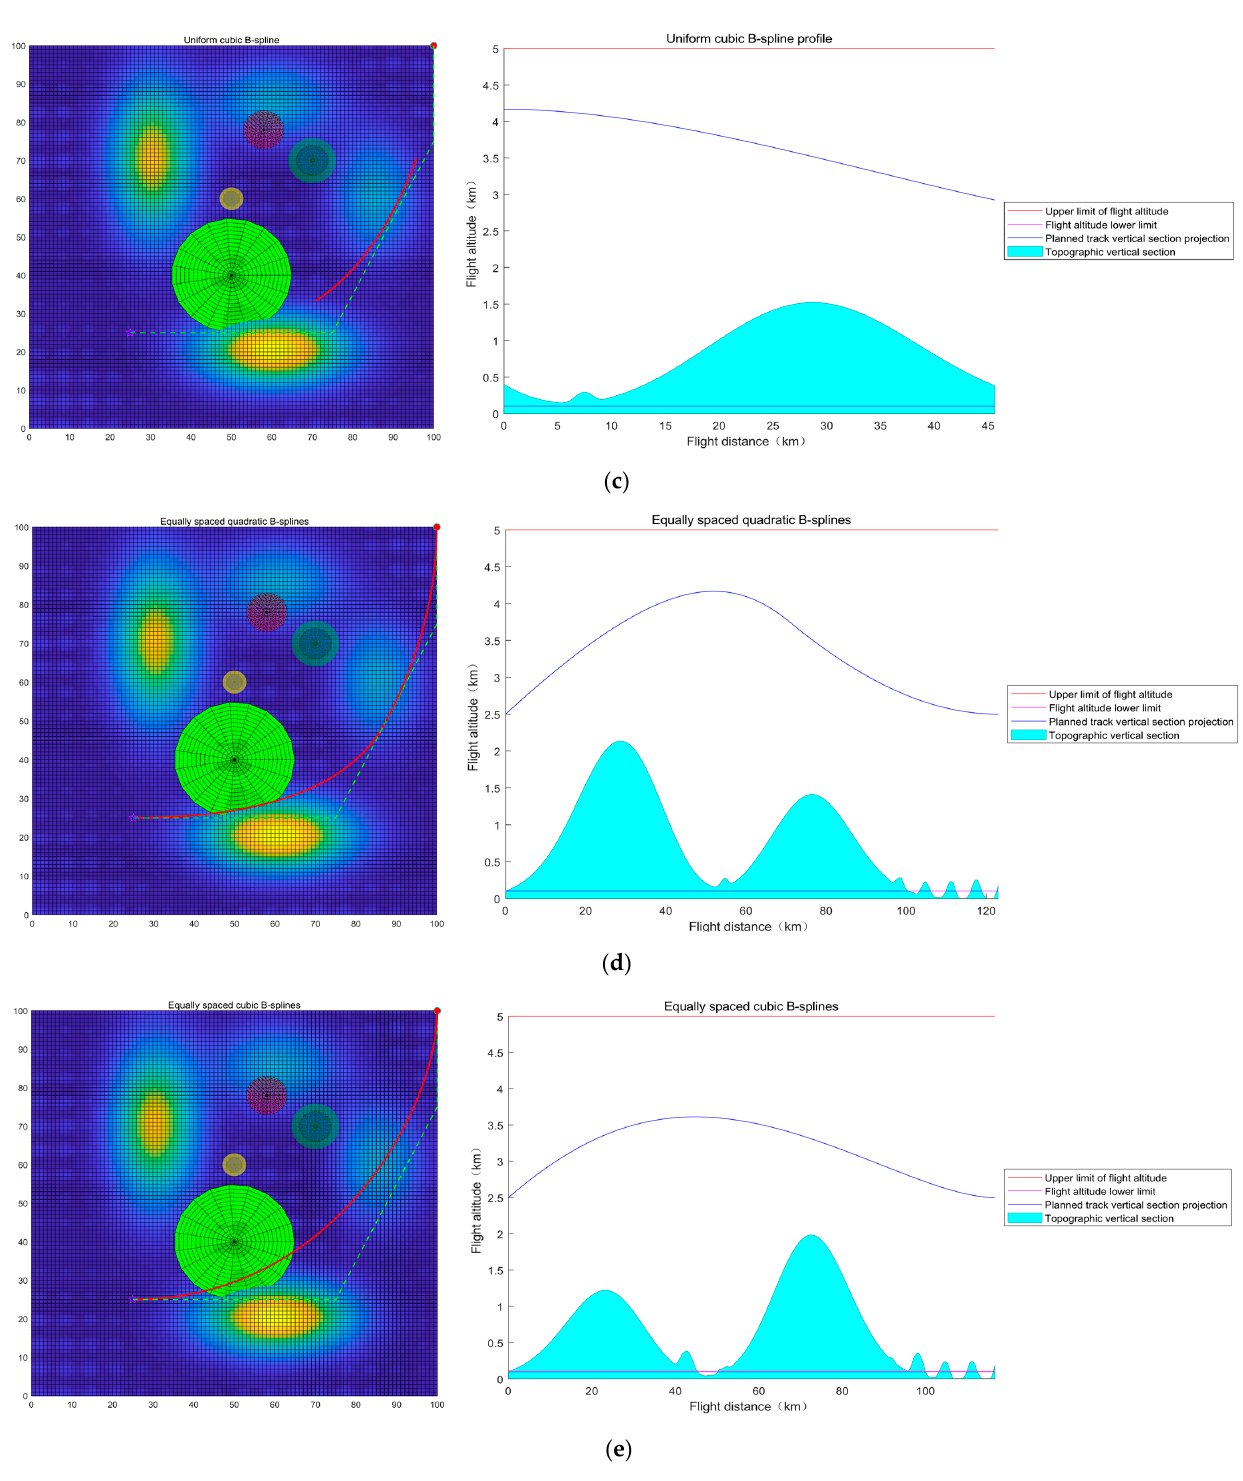
Figure A6. Top view and altitude curve after route smoothing. ( a ) Original route, ( b ) Uniform quadratic B-Spline smoothing, ( c ) Uniform cubic B-spline smoothing, ( d ) Equally spaced quadratic B-spline smoothing, and ( e ) Equally spaced cubic B-spline smoothing.